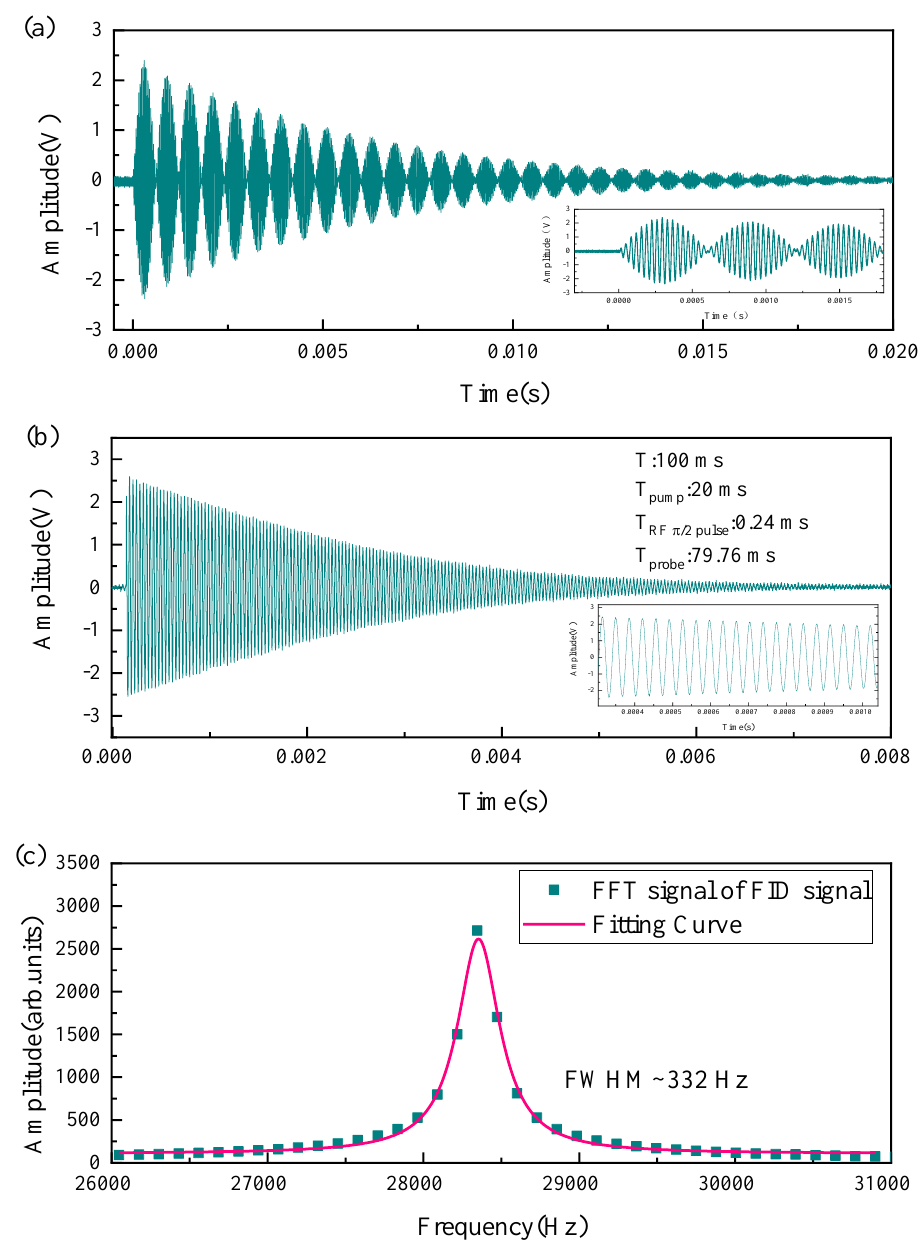
Figure 3. ( a ) Magnetic resonance signal with RF magnetic field; ( b ) FID signal; ( c ) FFT of the FID